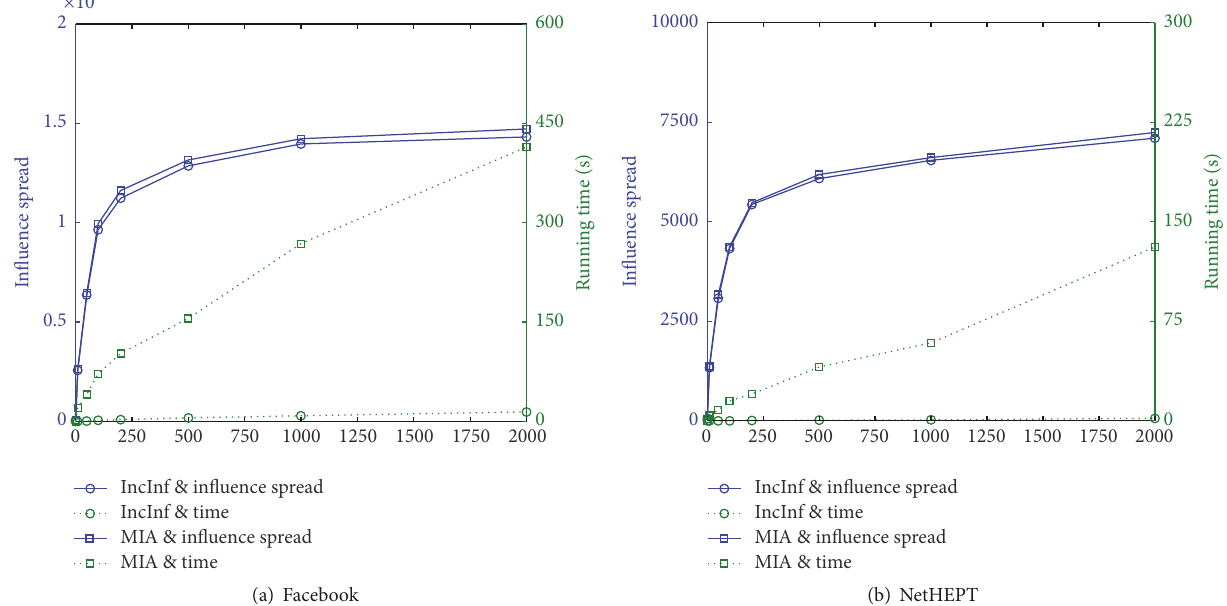
Figure 8: The effect of tuning of 𝜃 on running time and influence spread.